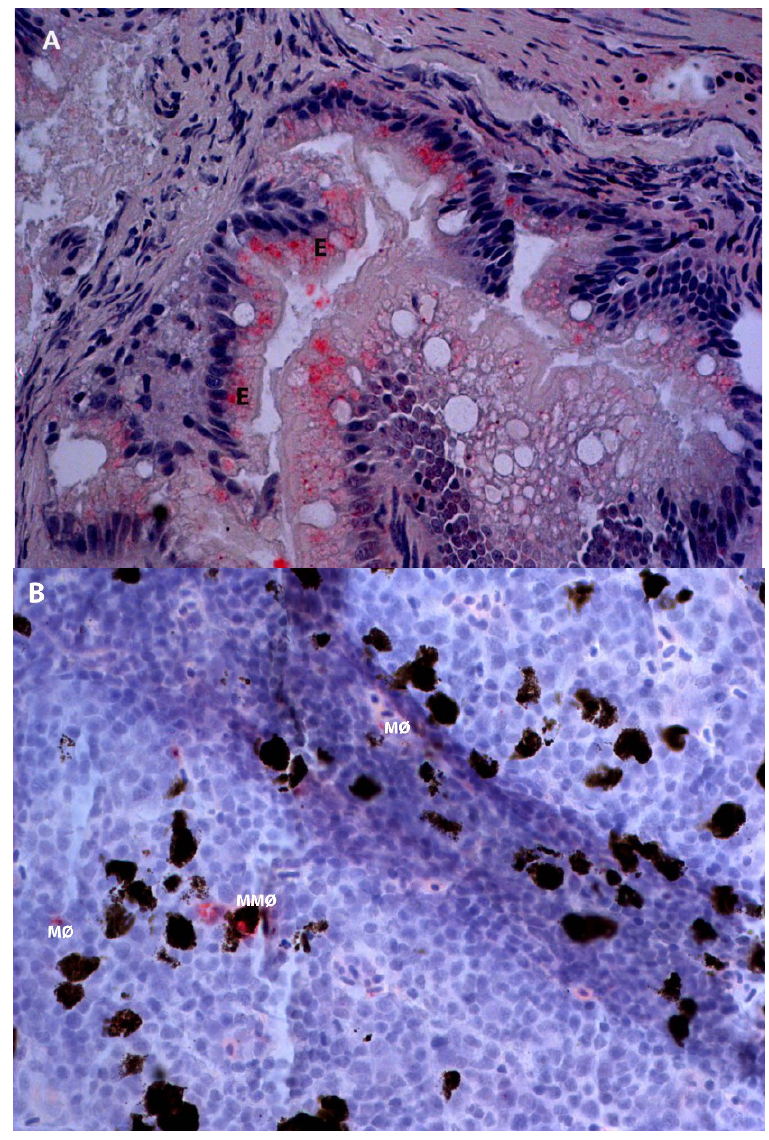
Figure 3. Infectious pancreatic necrosis virus antigens (red stain) in different tissues of Atlantic salmon at designated time points following oral or anal